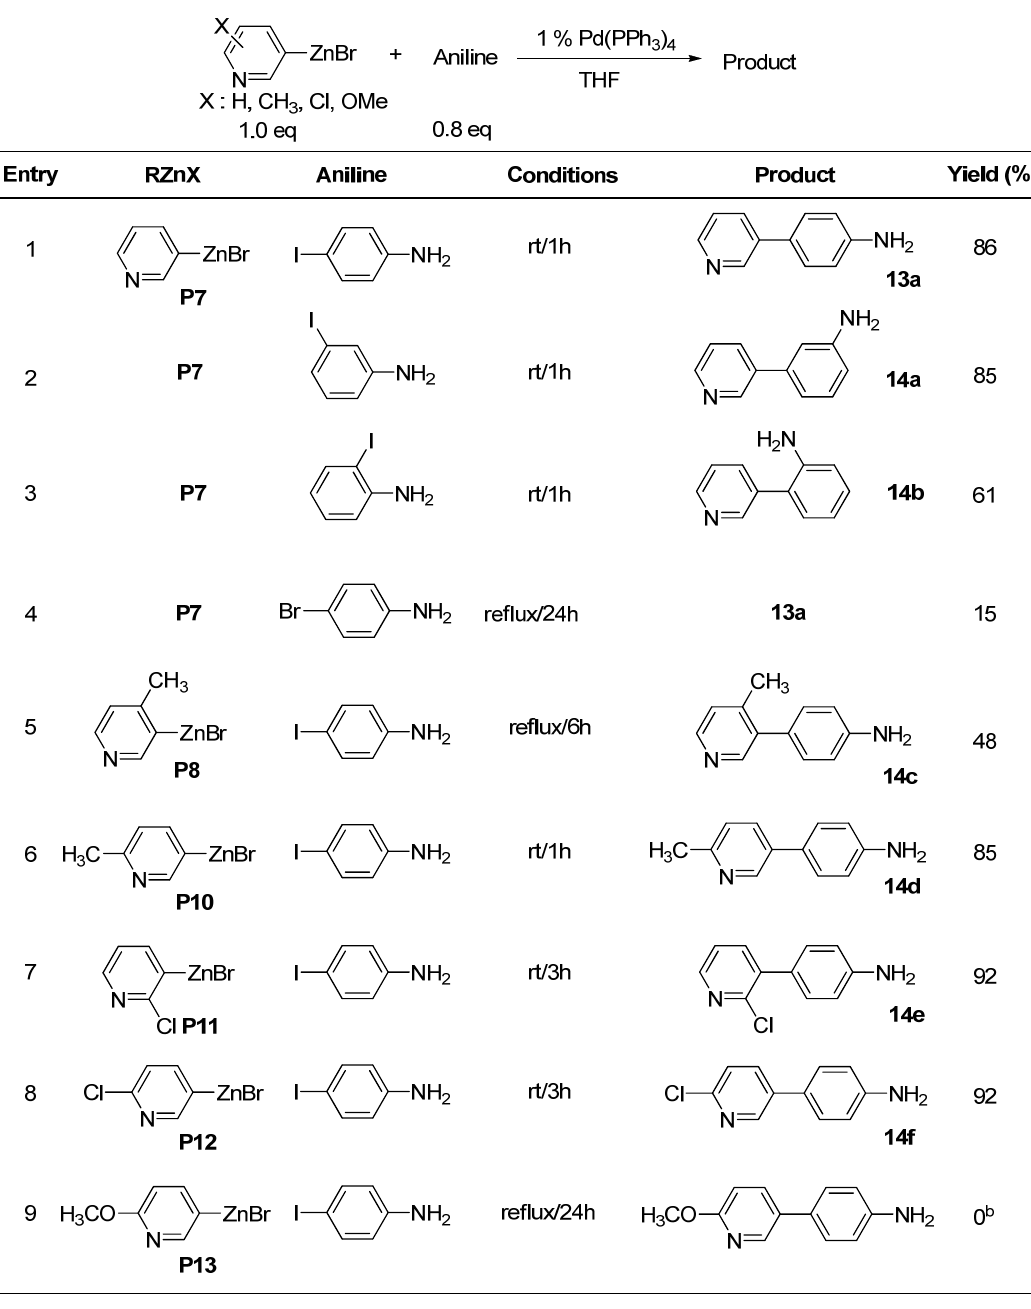
Table 14. Preparation of